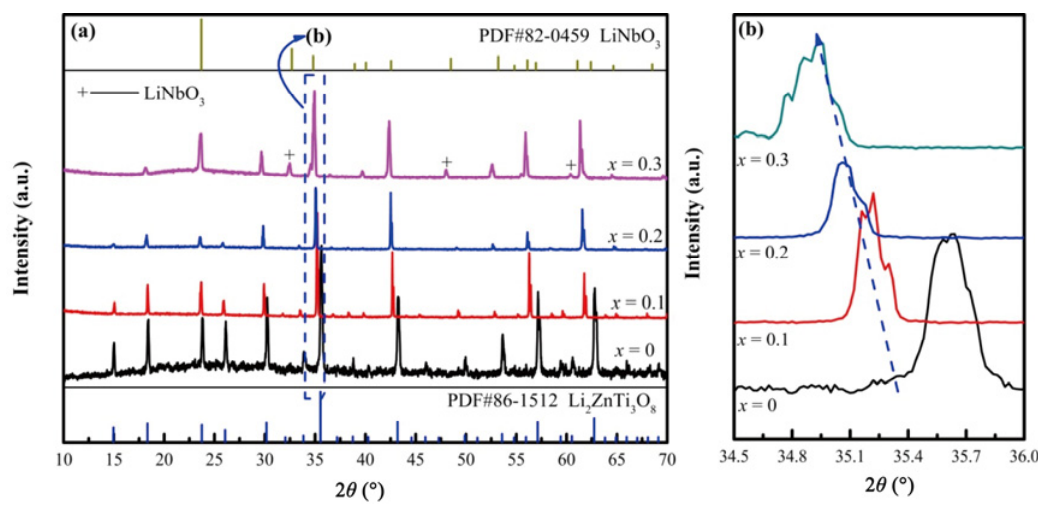
Fig. 1 (a) XRD patterns of LZTNN x ceramics sintered at their optimum temperatures and (b) amplified profile of XRD patterns at